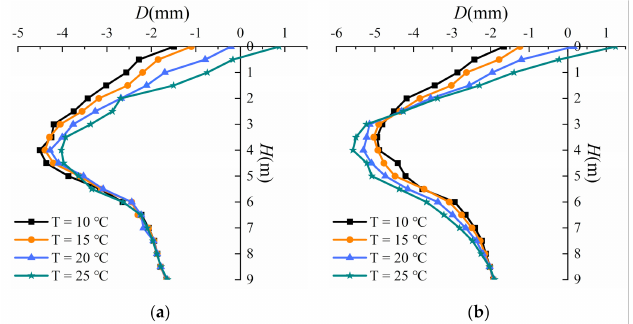
Figure 7. The displacement-temperature relationship of ( a ) pile 2 and ( b ) pile